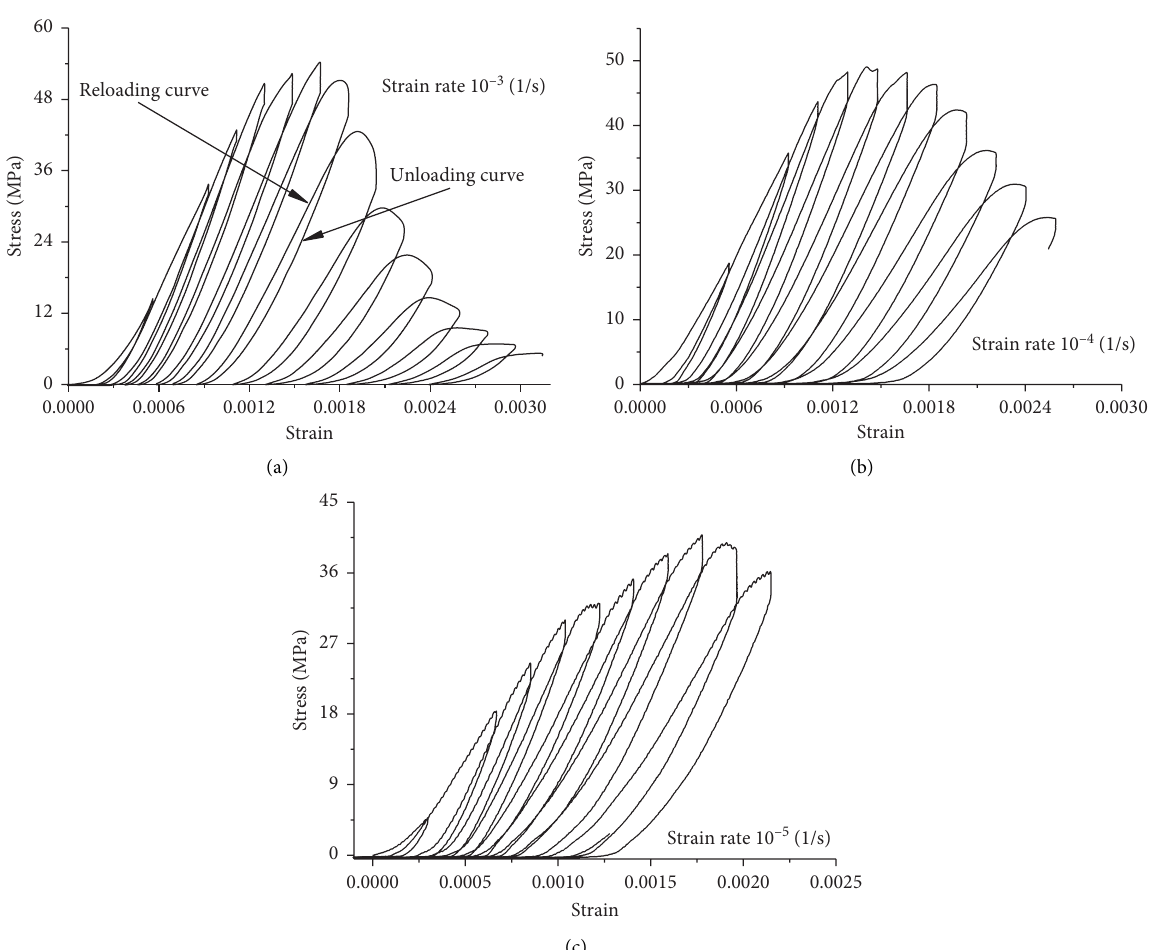
Figure 1: Schematic diagram of a cyclic uniaxial compression test.